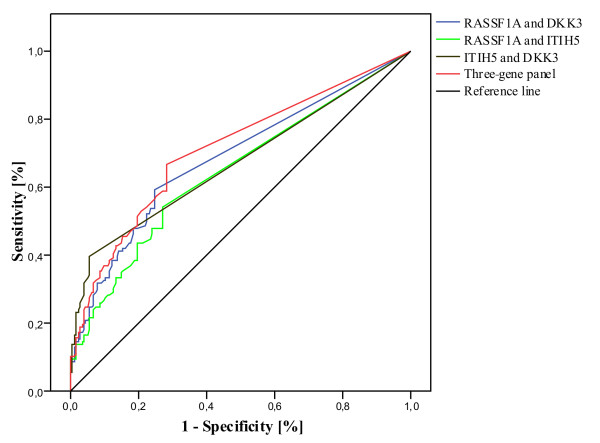
ROC-curve analysis of the three-gene panel in control samples including age-matched healthy and benign disease controls. ROC curves were established for different biomarker combinations to determine a cutoff value. A cutoff value of 0.085% methylation was defined for positive detection of disease; the specificity of the panel increased to 80.5% with a sensitivity of 51.4%. ROC analysis revealed an area under the curve (AUC) of 0.712 (95% CI, 0.653 to 0.770).